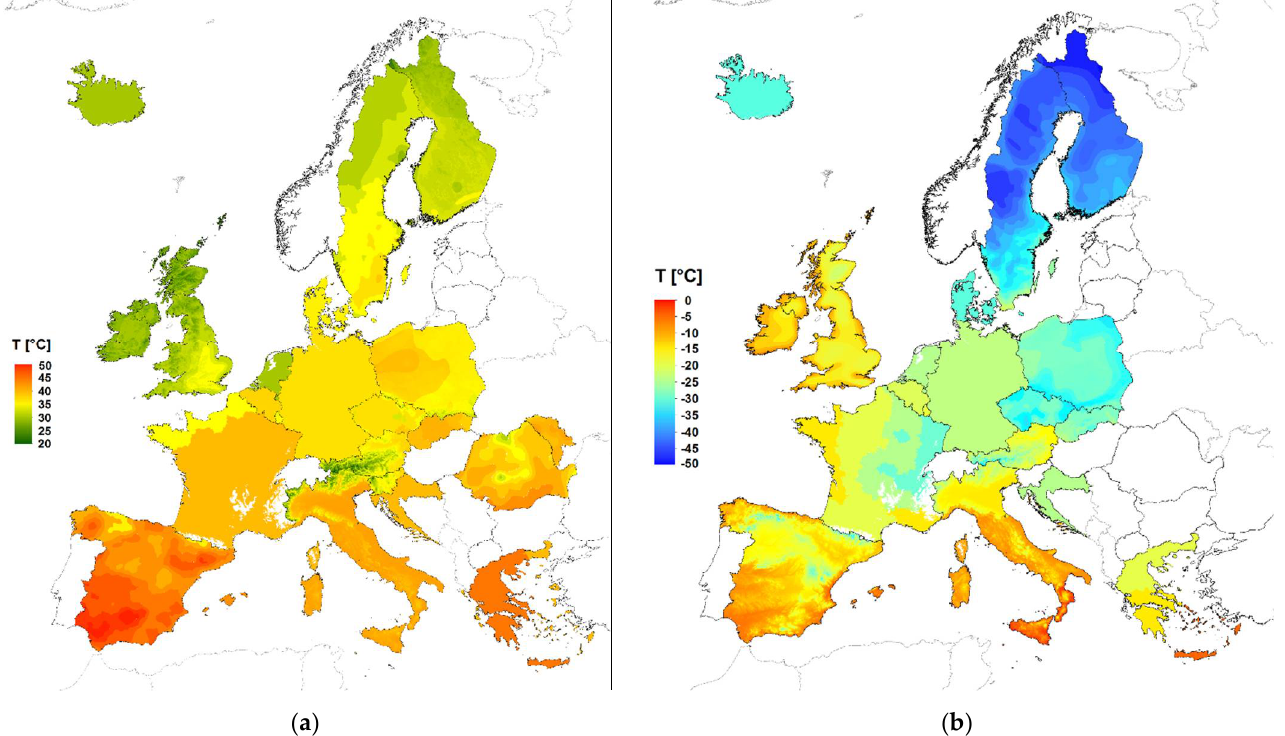
Figure 2. Maximum ( a ) and minimum ( b ) air shade temperature maps, T max and T min with an annual probability of exceeded of 0.02, based on available National Annexes to EN1991-1-5 “Actions on structures: Thermal actions”.